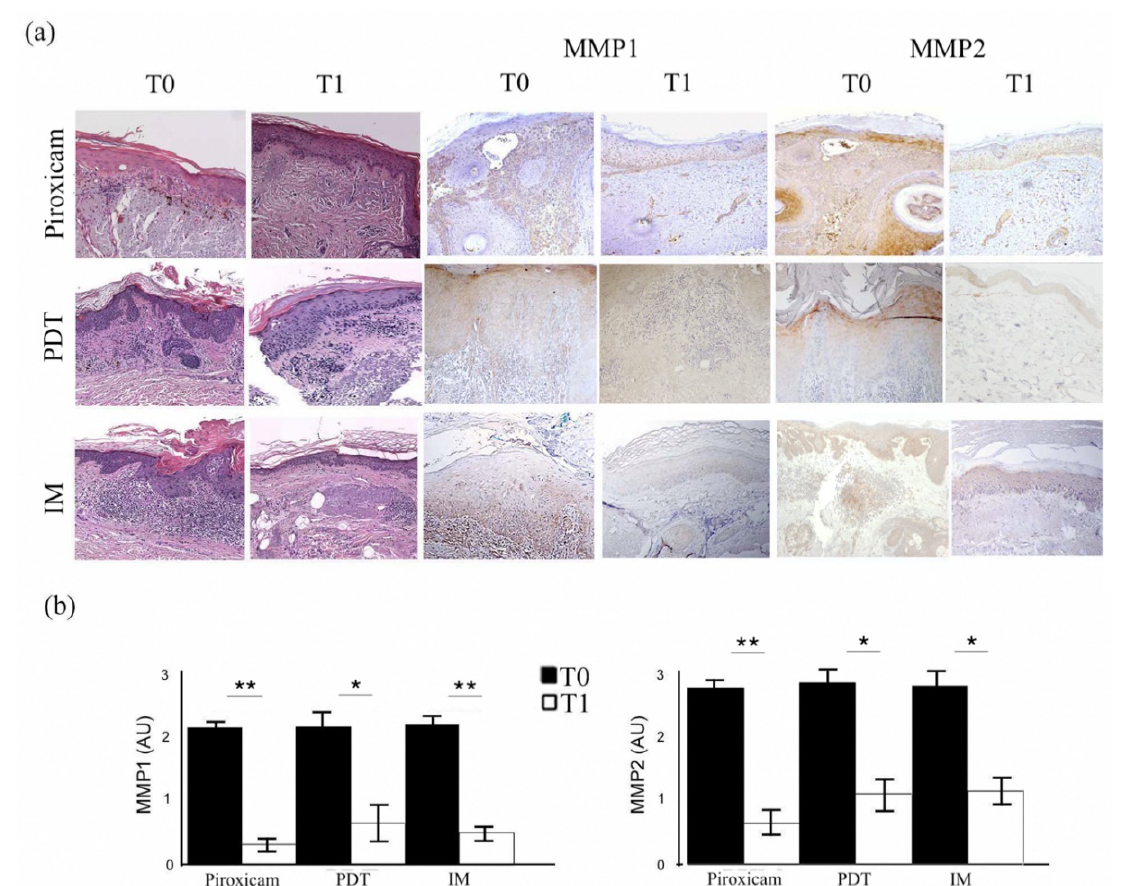
Figure 2. Histopathological features and metalloproteinase-1 and -2 expression in target lesions before (T0) and after treatment (T1). ( a ) The first two columns show the histopathological aspects of actinic keratoses before and after treatment with medical device 0.8% piroxicam and 50+ sunscreen, photodynamic therapy (PDT), and ingenol mebutate (IM) gel (hematoxylin–eosin, original magnification: 100 × ). The two central columns show images demonstrating the immunohistochemical expression of matrix metalloproteinase-1 (MMP1), while the last two show the staining for matrix metalloproteinase-2 (MMP2) in the target lesions before and after each treatment (original magnification: 100 × ). ( b ) Semiquantitative evaluation of matrix metalloproteinase expression before and after each therapeutic agent. * p < 0.01; ** p < 0.001.